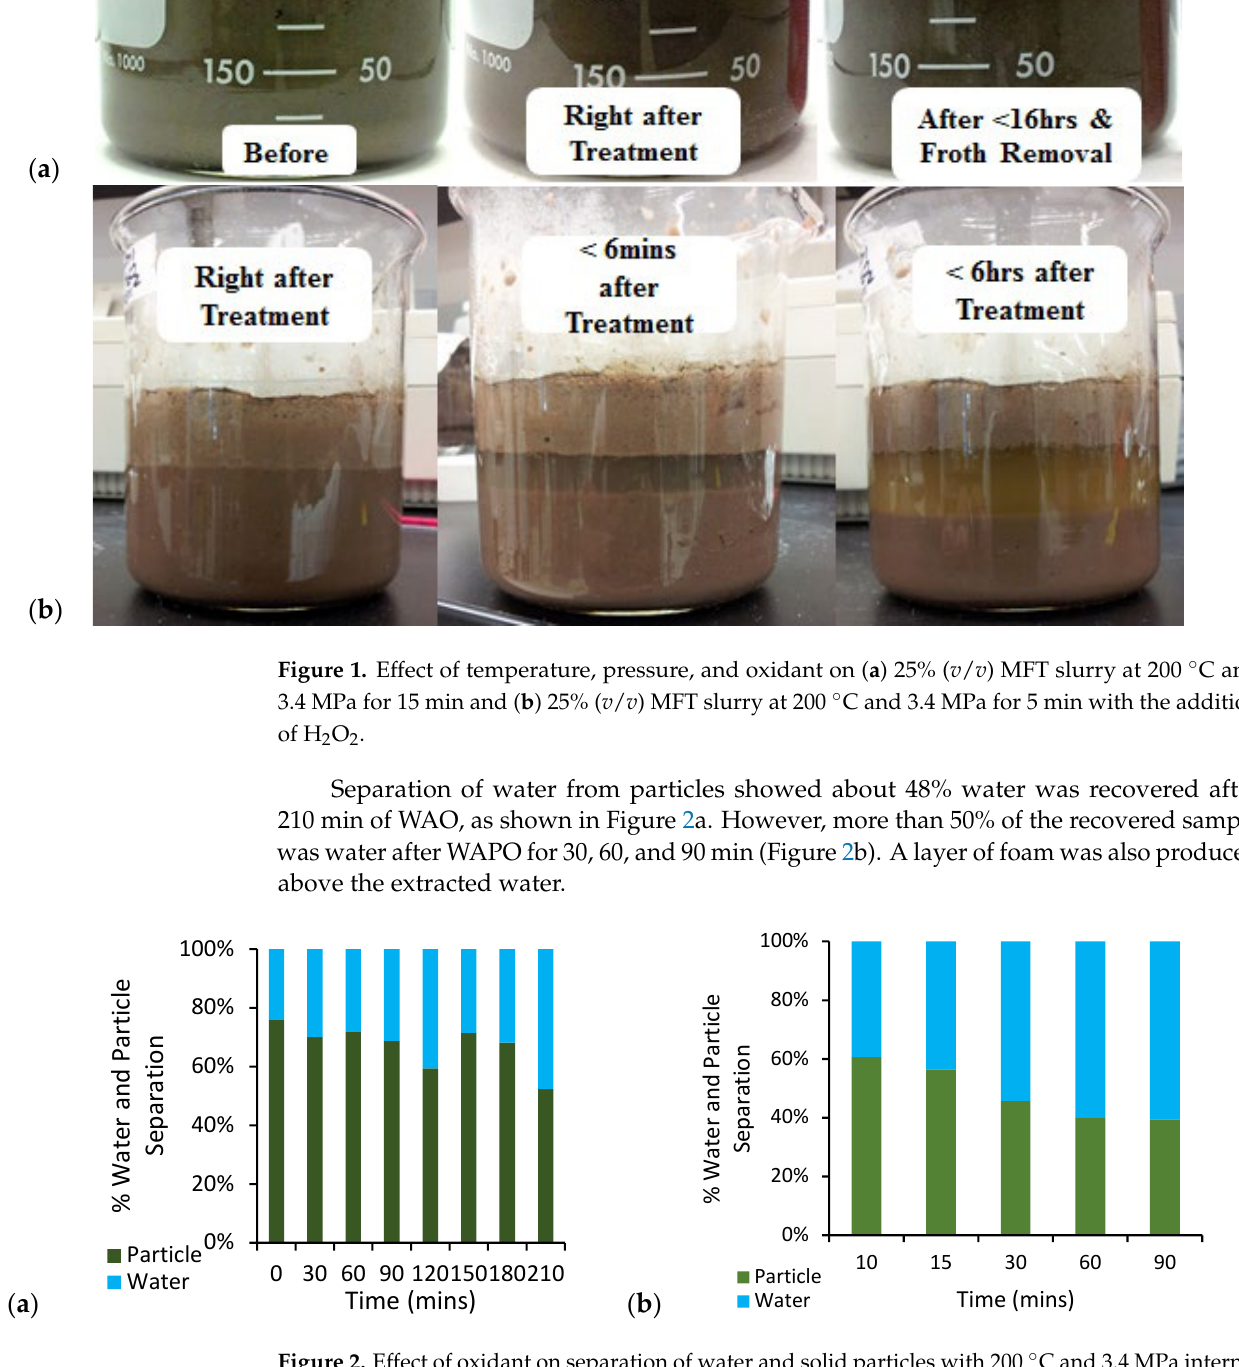
Figure 2. Effect of oxidant on separation of water and solid particles with 200 °C and 3.4 MPa internal pressure using ( a ) 0.7 MPa air and ( b ) 0.7 MPa air + 5 mL H 2 O 2 .